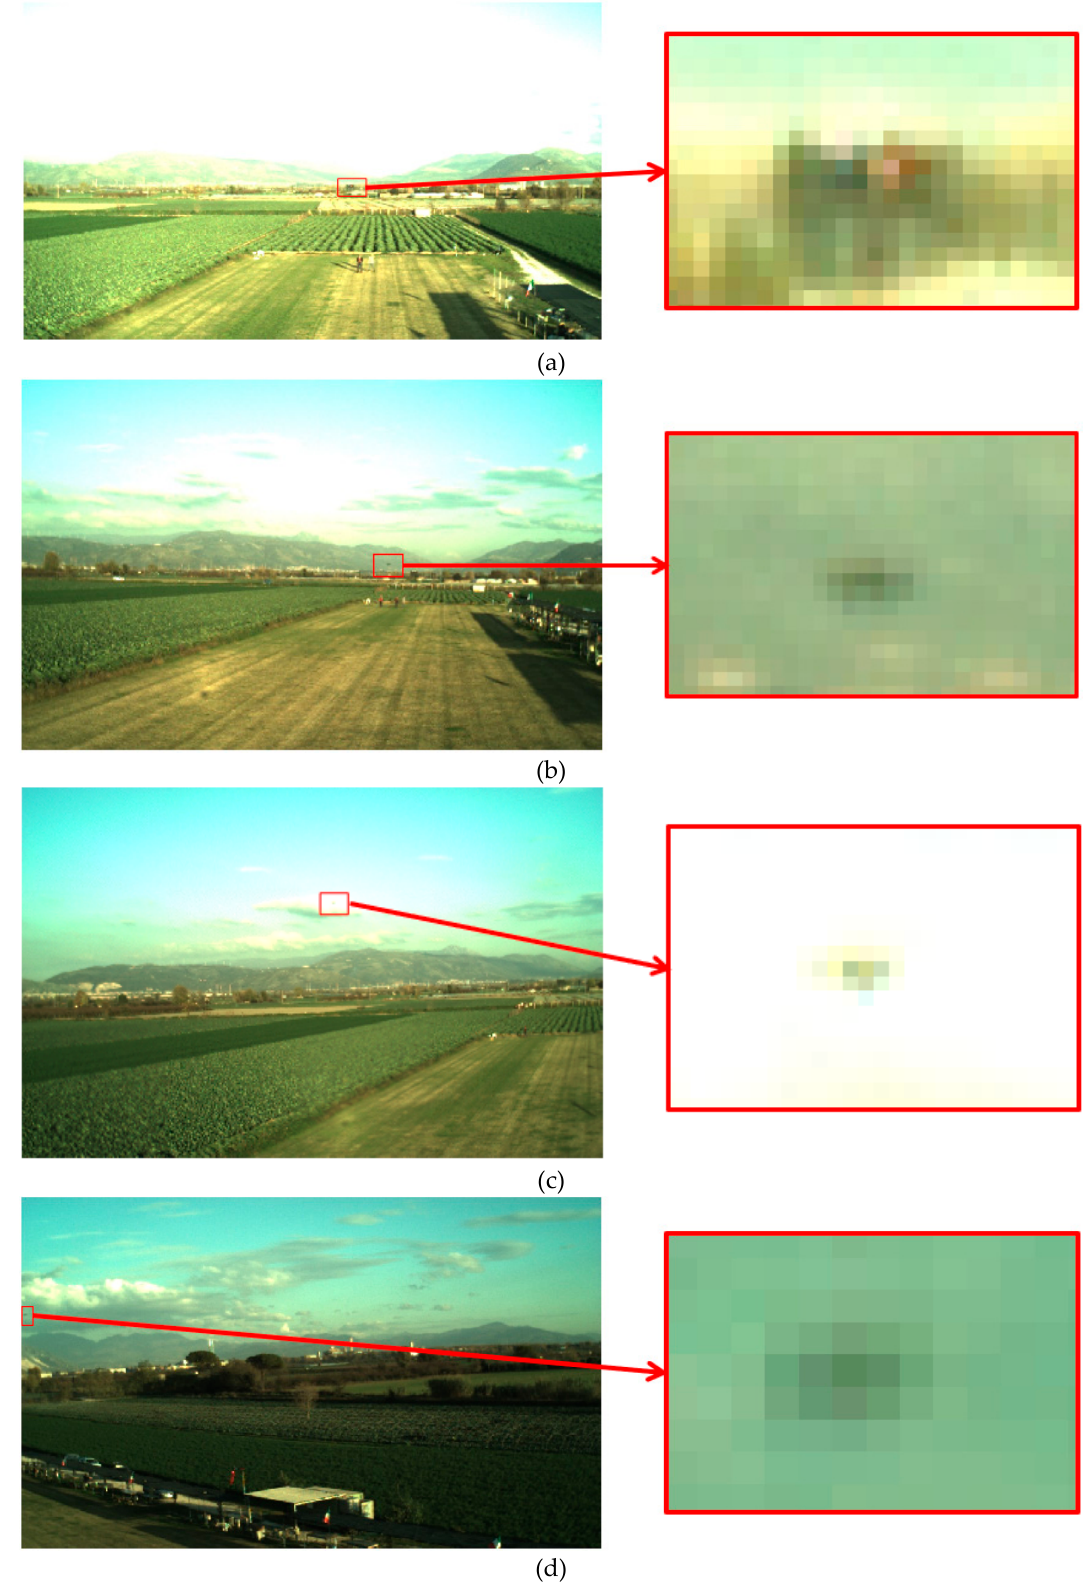
Figure 11. Example of images from FT3-A. The target (i.e., the X8 + octocopter) occupies a few pixels as highlighted by the zoom on the right side of each figure. ( a , b ). Target below the horizon. ( c , d ) Target above the horizon hindered by clouds.